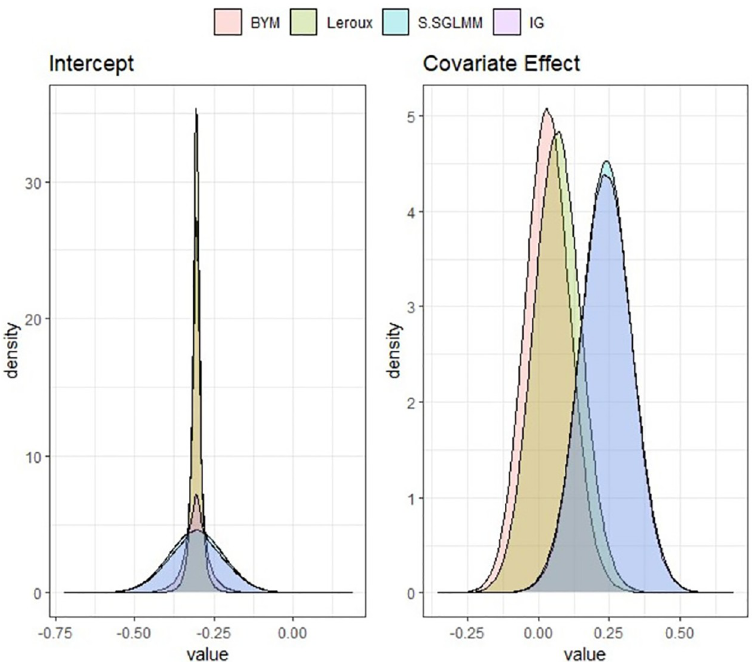
Fig 4. Posterior densities of regression coefficients β 0 and β 1 using Bayesian parametric spatial models for North Carolina SIDS data.